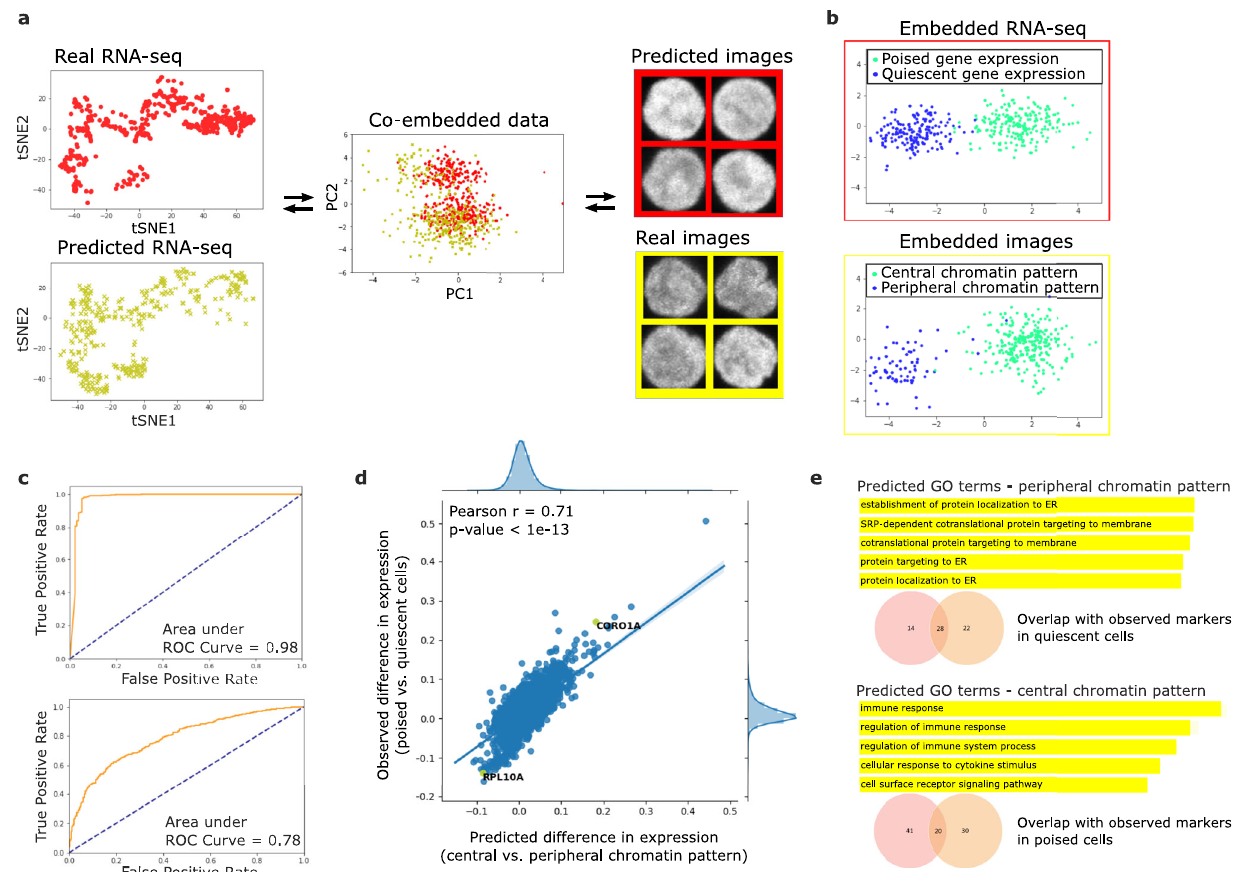
Fig. 4 Integration of single-cell RNA-seq data and single-cell nuclear images of naive T-cells using our methodology allows translating between chromatin packing and gene expression pro fi les. a Illustration of data integration and translation: (left) t-SNE plots of observed single-cell RNA-seq data (red) and single-cell RNA-seq data translated from single-cell images (yellow); (middle) PCA visualization of single-cell RNA-seq data (red) and single-cell imaging data (yellow) embedded in 128-dimensional latent space; (right) examples of observed single-cell images (yellow) and images translated from single-cell RNA-seq data (red). b – e Evidence that our data integration methodology correctly aligns gene expression features and imaging features. b Linear Discriminant Analysis (LDA) plots of single-cell RNA-seq (top) and imaging (bottom) datasets embedded in the latent space. The clusters with more quiescent (blue) and poised (green) gene expression programs from the RNA-seq dataset are aligned with the clusters with peripheral (blue) and central (green) chromatin patterns from the imaging dataset. c (top) Receiver Operating Characteristic (ROC) curve illustrating performance of a classi fi er trained to distinguish between peripheral and central chromatin patterns in images when evaluated on images translated from RNA-seq data. (bottom) ROC curve illustrating performance of a classi fi er trained to distinguish between quiescent and poised gene expression programs when evaluated on RNA- seq data translated from images. High performance of both classi fi ers indicates that the alignment of the clusters in the latent space in b also holds in the original gene expression and imaging spaces. The dotted line represents random guessing based on evenly-distributed classes. d Differential gene expression analysis between cells with central and peripheral chromatin pattern performed on the predicted gene expression matrix translated from images using our methodology. The predicted fold-change of gene expression based on images is strongly correlated with the observed fold-change of gene expression between quiescent and poised naive T-cells from the actual RNA-seq dataset. e Analysis of gene ontology (GO) enrichment terms of cells with central and peripheral chromatin pattern based on the predicted gene expression matrix translated from images using our methodology shows a high overlap between predicted markers (orange) from the imaging dataset and actual markers (red) from the RNA-seq